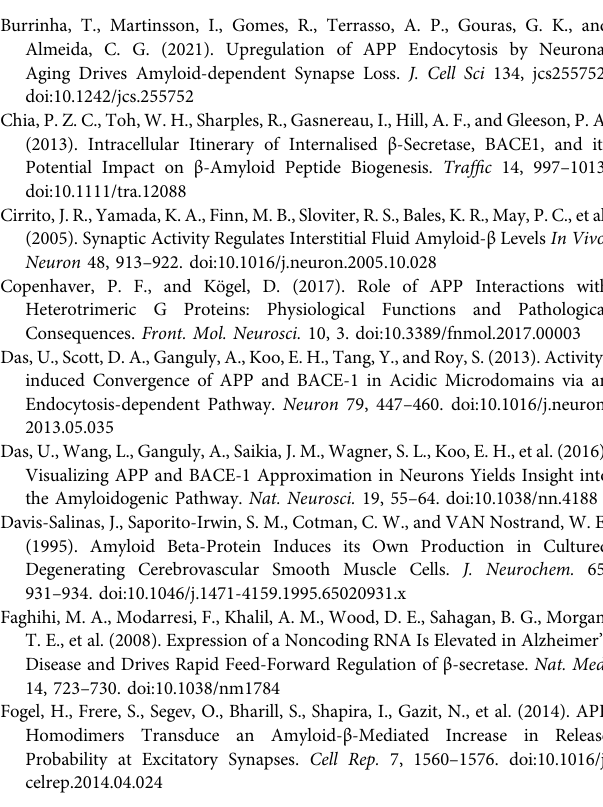
difference among conditions was found by ANOVA. Inserts are x2.5 enlargement of the corresponding image. Scale bar is 10 μ m. Supplementary Figure S2 | Characterization of A β species and 12F4 antibody speci fi city by dot blot. Expression of APP:VN and BACE1:VC plasmids in N2a cells. (A) . Dot blot analysis of A β species used in this work. Soluble non-aggregated A β 1-42 (m A β ), A β 1-42 oligomers (o-A β ), and A β 1-42 fi brils (f-A β ). Upper panel was revealed with the conformation-independent monoclonal antibody 4G8 that recognizes all A β species. Middle and lower panels were stained with conformation-dependent antibodies NU1 and NU4, which selectively label oligomeric species. Note that NU1 strongly labeled o-A β , while weakly recognized f-A β . NU4 antibody only labeled o-A β . (B) . Transfected N2a cells with APP:VN and BACE:VC plasmids and treated as indicated. Cultures were fi xed and immunostained with antibody against GFP (Molecular Probes) followed by Alexa Fluor 598-conjugated antibody (Invitrogen) and imaged by confocal microscopy. Left panel depicts GFP stain, and right panel depicts BiFC. Note thatforsimilarlevelofexpressionof fl uorescentprotein(anti-GFPstain),levelofBiFC intensity variesaccording totreatment. Also,gallein and A β treatmentsdid not affect the expression of fl uorescent protein. Scale bar is 10 µm. (C) . Equal amounts of monomers of A β 42 were analyzed by dot blot using 12F4 antibody at speci fi ed concentrations. (D) . Indicated peptides (1 µg) were analyzed by dot blot using 12F4 antibody. Note that 12F4 antibody speci fi cally labeled A β 42. SupplementaryFigureS3| Establishmentandcharacterizationofhumanneuronal cultures. (A) .Schematicprotocolfordifferentiatinghuman-induced pluripotentstem cells (iPScs) to neurons. Phase contrast images of an iPSC colony, embryonic bodies (EB) in suspension, neural epithelium (NE) and neural rosettes, and differentiated neurons are shown. Scale bar is 50 µm. (B) . Confocal images of human neuronal cultures at 21 DIV immunolabed for the indicated proteins. Scale bar is 10 µm. Supplementary Figure S4 | Effect of f-A β on viability of iPSc-derived human neurons. (A) . Phase contrast images of cultures of human neurons derived from iPSc treated with vehicle or 10 mM f-A β 25-35 are shown. Upper panel 20x lower panel×40. (B) .Viability wasassessed byscoringviableandapoptotic nucleistained with DAPI (ANOVA F(1,4) = 0.27607, P = 0.627). Scale bar is 50